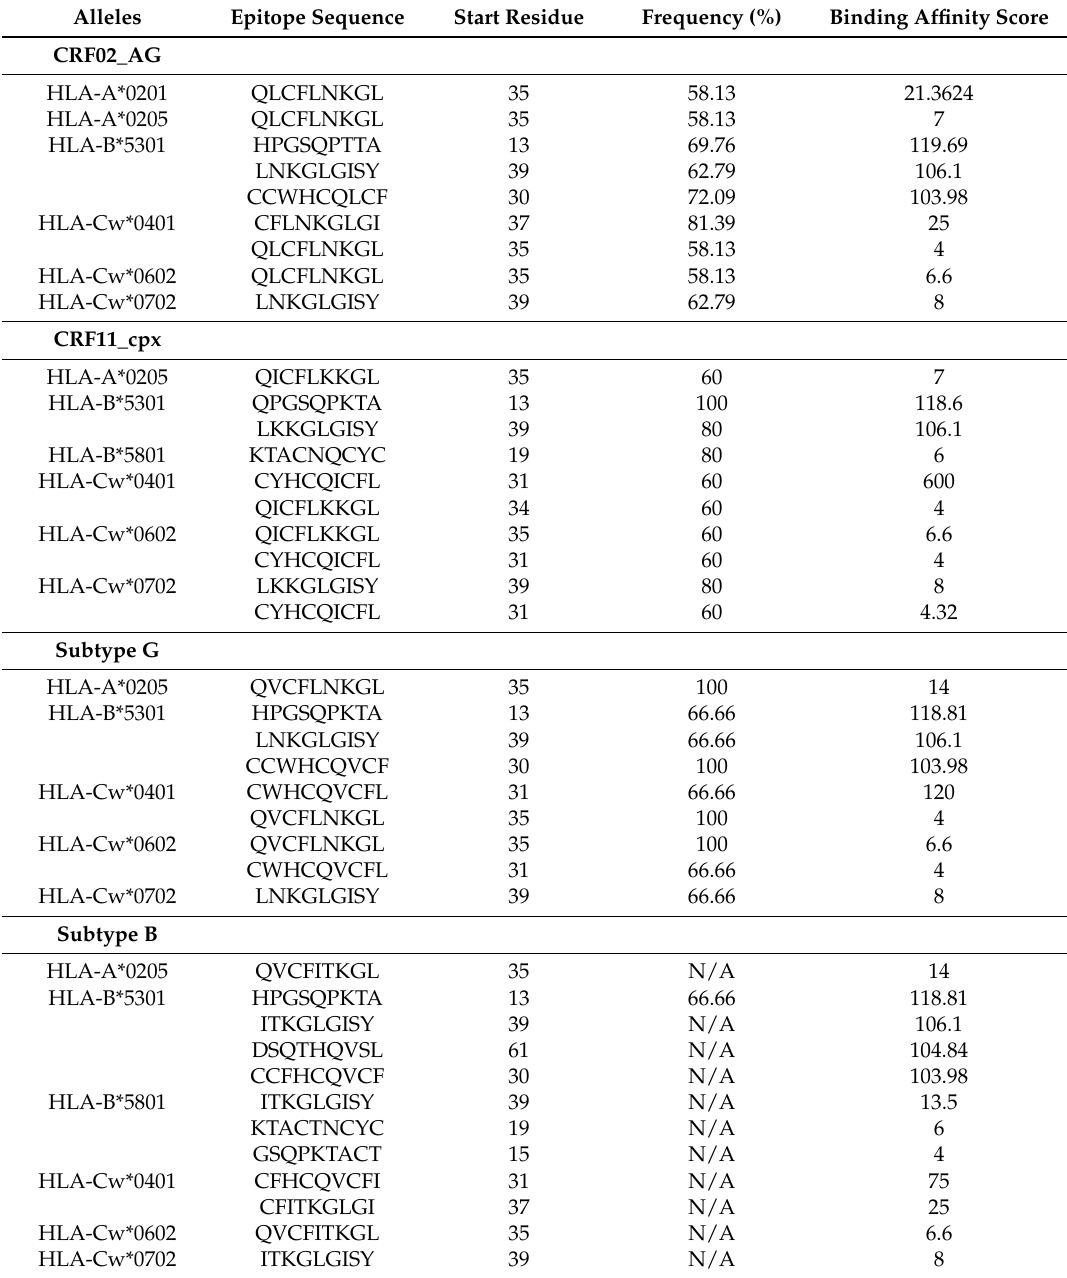
Table 4. HLA binding epitopes of Tat exon-1 sequences present in Cameroon HIV-1 isolates and subtype